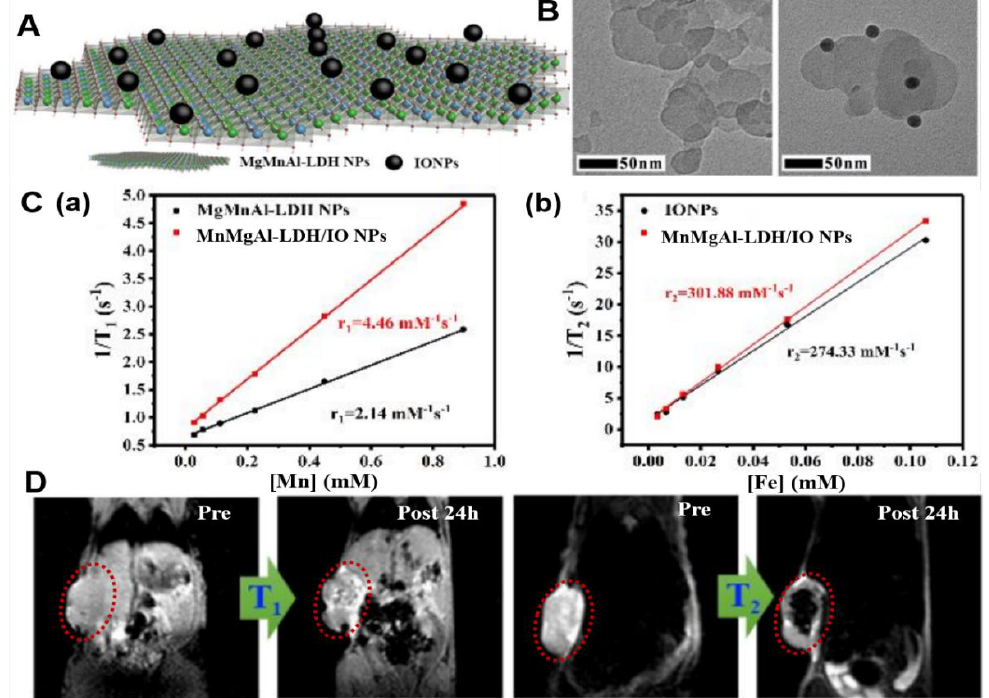
Figure 6. ( A ) Schematic illustration of MnMgAl-LDH / IO NPs, ( B ) TEM images of MnMgAl-LDH (left) and MnMgAl-LDH / IO NPs (right), ( C ) analysis of relaxation rate 1 / T 1 vs. Mn ( a ) and 1 / T 2 vs. Fe ( b ) concentration for contrast agents at pH 6.5, ( D ) T 1 -and T 2 -weighted MR images of breast tumor bearing mice before and after intratumoral injection of BSA / MnMgAl-LDH / IO NPs, reproduced from [12], with permission from American Chemical Society, 2019.